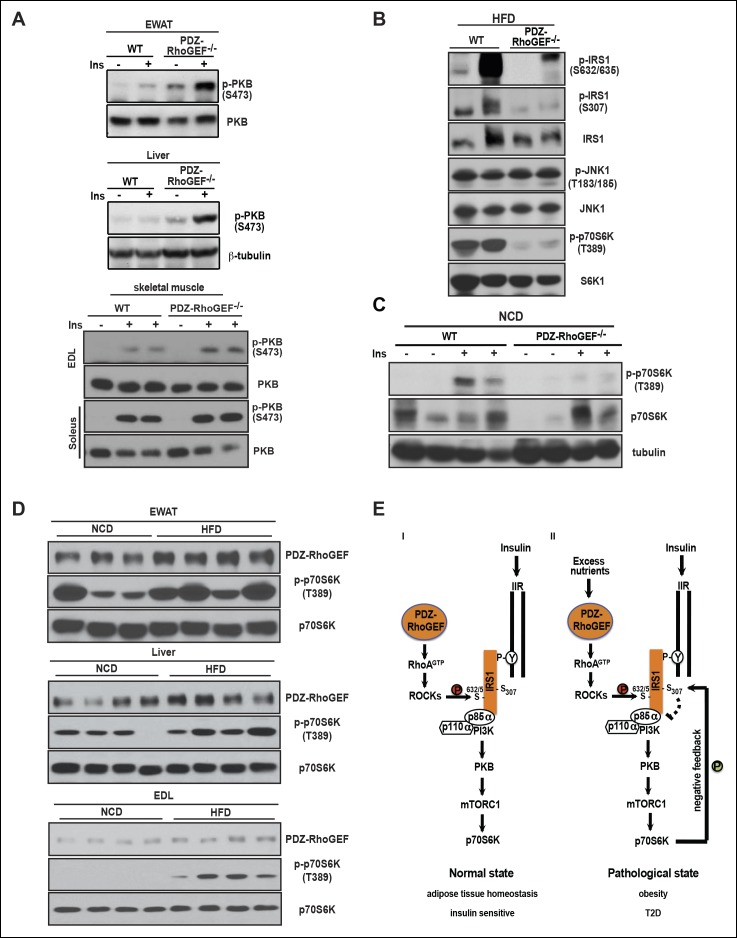
PDZ-RhoGEF contributes to the HFD-induced insulin resistance through a S6K1-mediated negative feedback.(A) Western blot analysis of insulin-mediated PKB/Akt phosphorylation in peripheral tissues: EWAT, liver, and skeletal muscles (EDL and soleus). (B) Phosphorylation status of IRS1 S632/635, S307, JNK1 T183/185, and p70S6K1 T389 in EWATs from HFD-fed WT and PDZ-RhoGEF KO mice. (C) Phosphorylation of p70S6K1 T389 in EWATs from NCD-fed WT and PDZ-RhoGEF KO mice after in vivo insulin stimulation. (D) Differential protein levels of PDZ-RhoGEF in EWAT of NCD- and HFD-fed wild type mice. (E) PDZ-RhoGEF modulates insulin/IGF-1 signaling to impact adipose tissue homeostasis (I) and susceptibility to dietary-induced obesity and T2D (II).